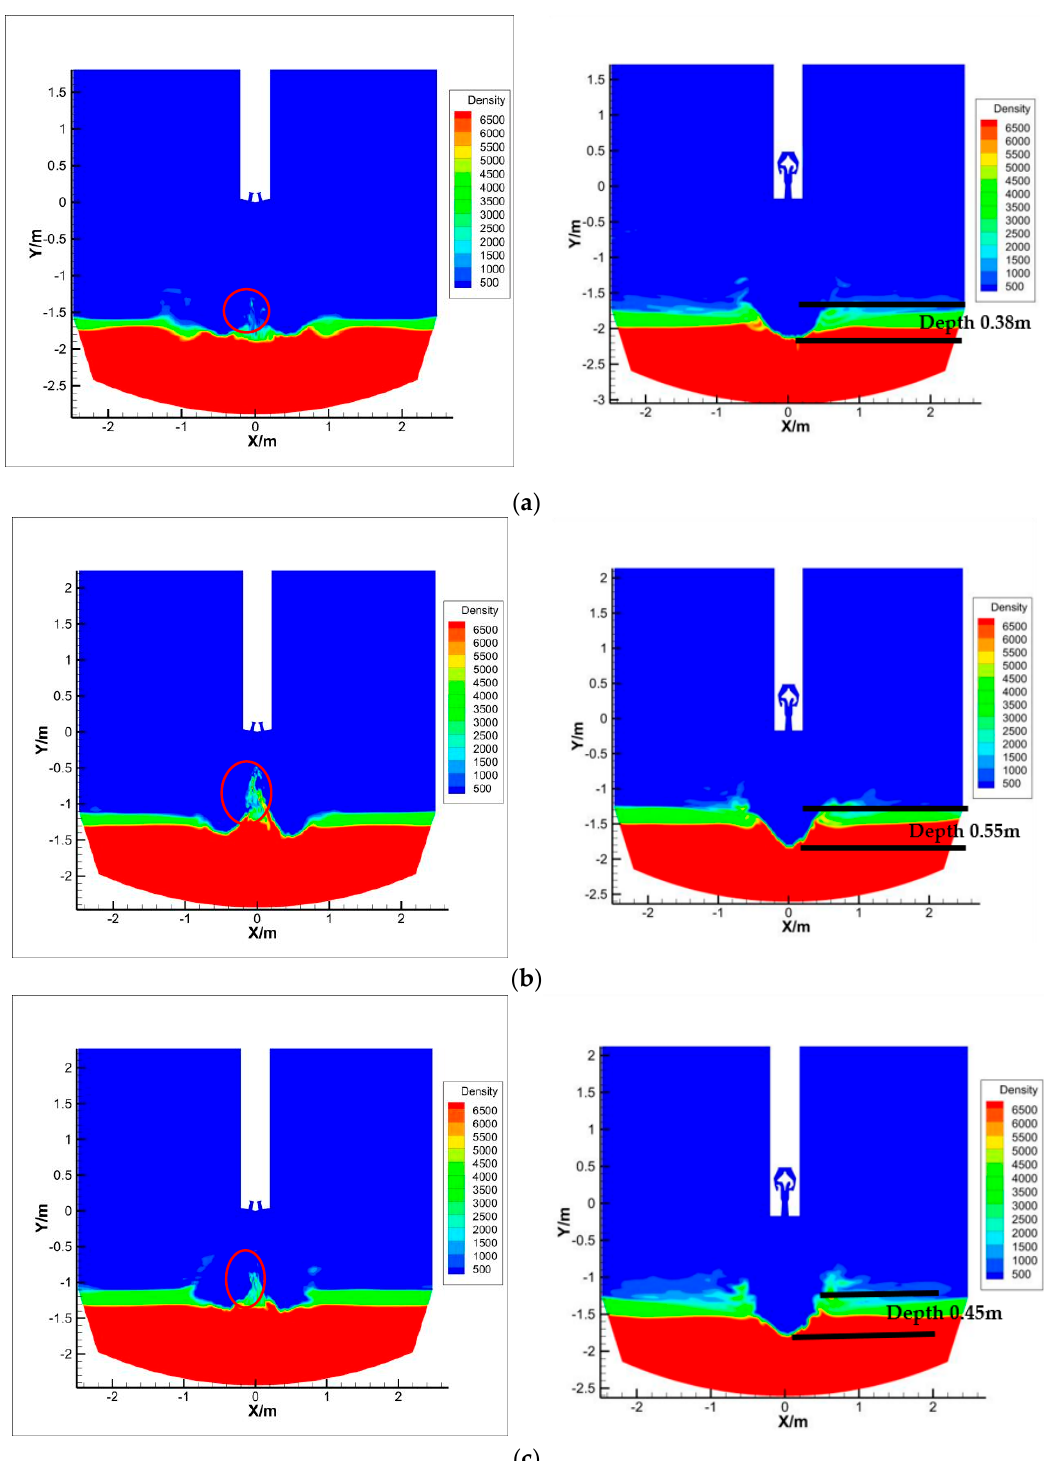
Figure 10. Comparison of interaction behavior between Laval and cyclone oxygen lances under different parameters: ( a ) comparison of interaction behavior between Laval and cyclone oxygen lances (lance height 1550 mm, operation pressure 1.0 Mpa); ( b ) comparison of interaction behavior between Laval and cyclone oxygen lances (lance height 1100 mm, operation pressure 1.0 Mpa); ( c ) comparison of interaction behavior between Laval and cyclone oxygen lances (lance height 1100 mm, operation pressure 0.8